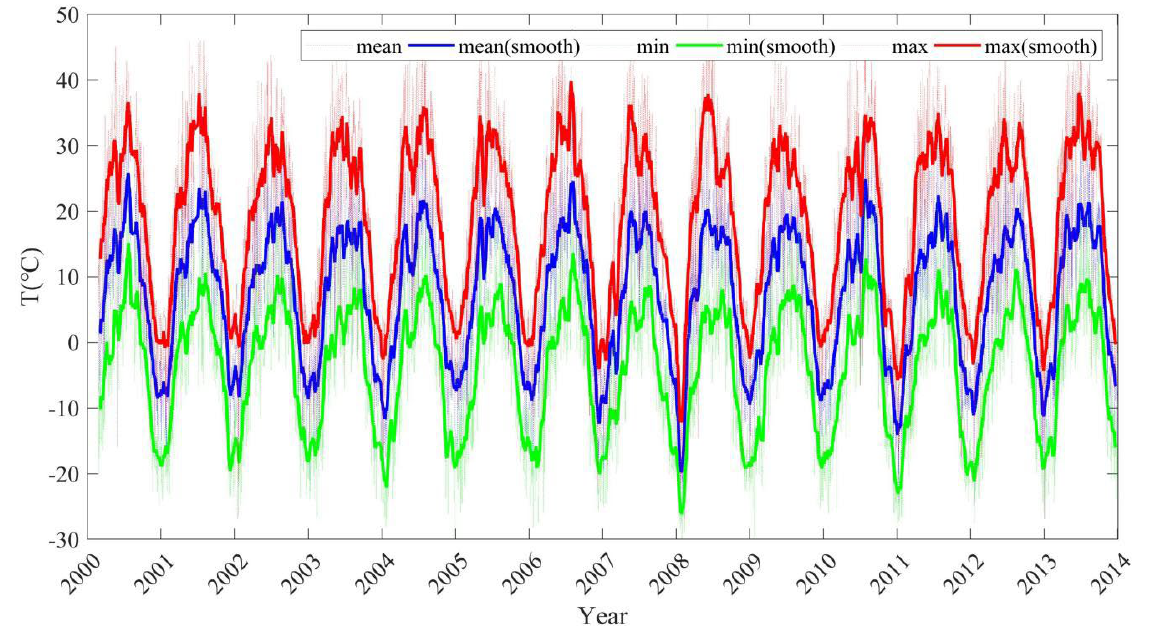
Figure 3. The glacier surface temperature data for the Qiyi Glacier. In the figure, we have shown the daily mean, minimum and maximum temperatures from MOD11A1 and MYD11A1 products.